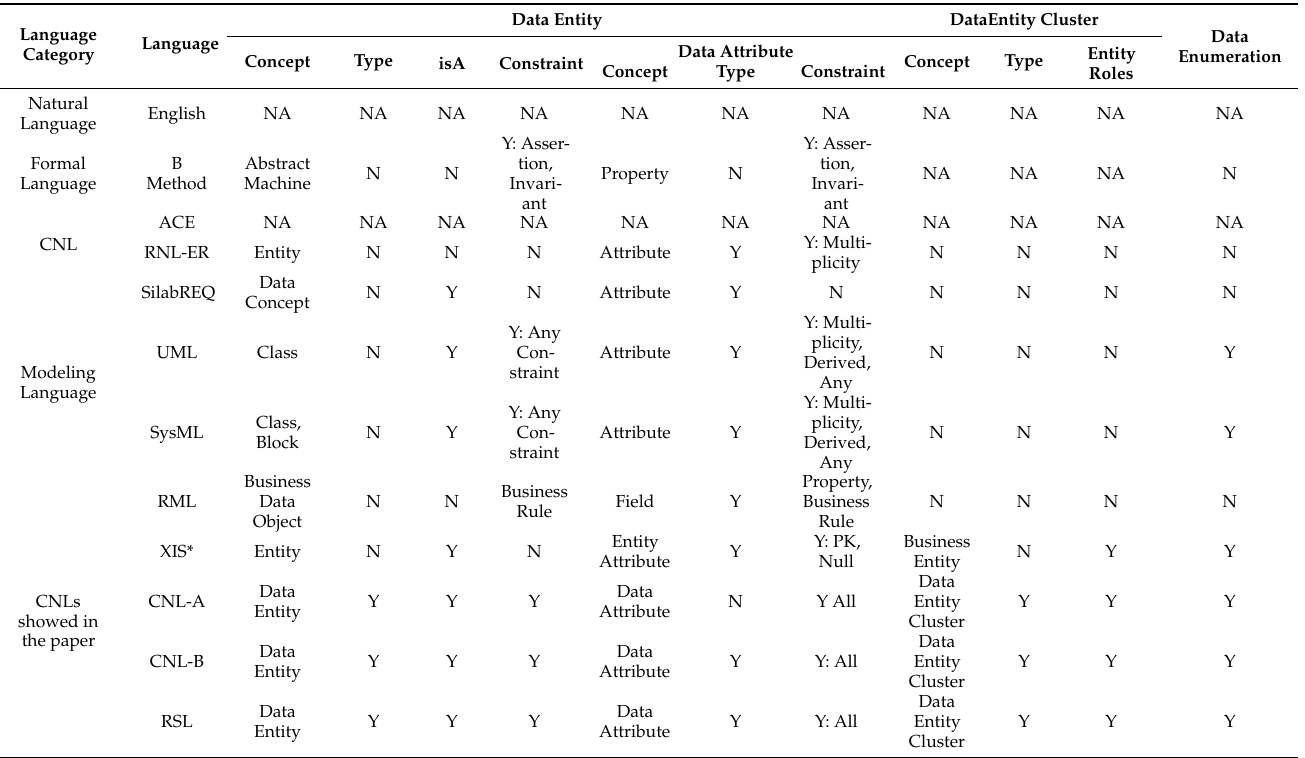
Table 3. Comparison of languages used for data entity specification and data modeling: Concepts supported. Language